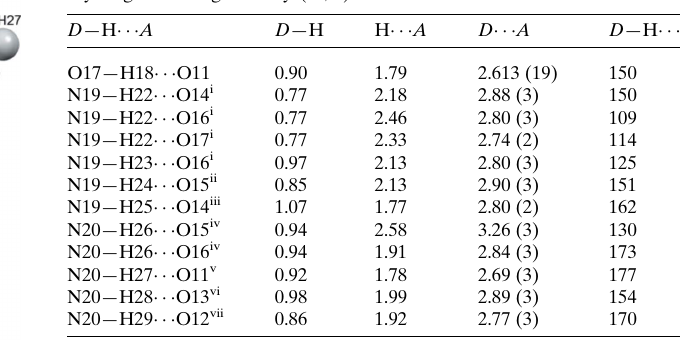
Table 1 Hydrogen-bond geometry (A˚ , (cid:5)